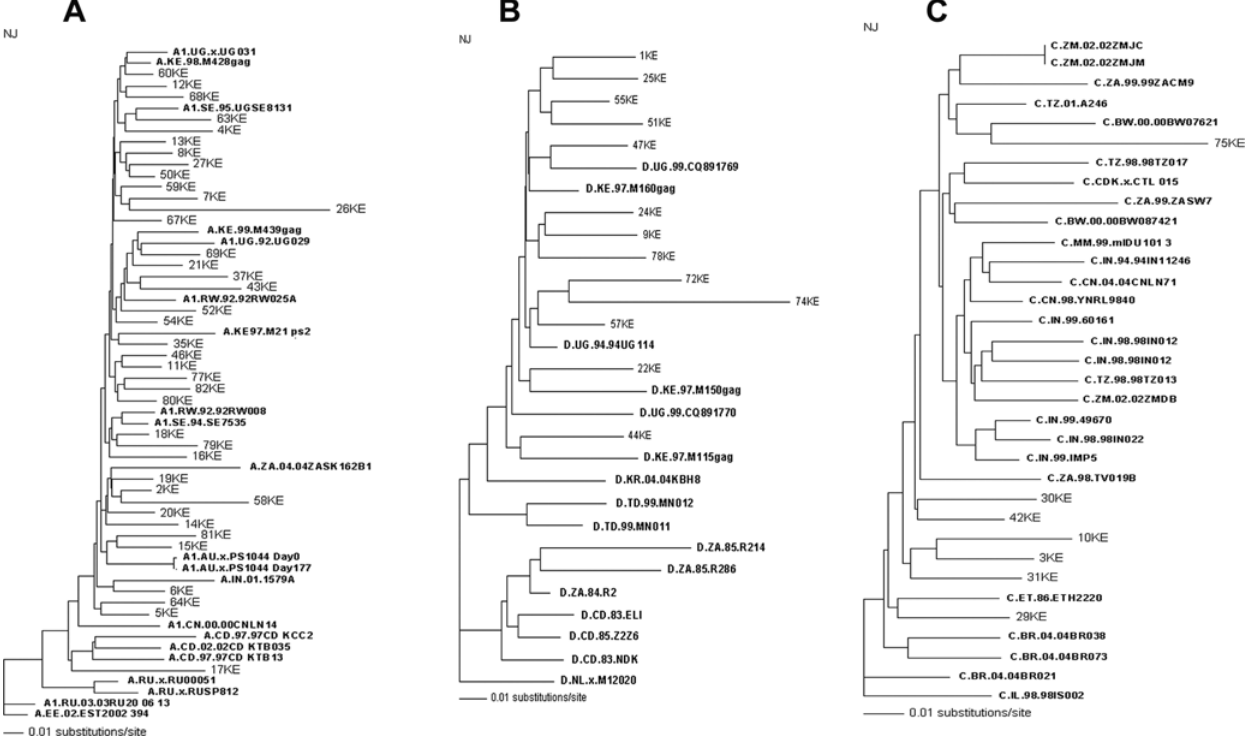
Figure 2. Neighbor-Joining Phylogenetic trees of the three most represented subtypes, A (Fig. 2A), D (Fig. 2B) and C (Fig. 2C), depicting geographical associations of the studied sample group with other global regions. Reference Sequences from Los Alamaos Database have been indicated in bold. Out groups selected for Fig. 2A, B, and C were, respectively, A.EE.02.EST2002 394, NL.x.M12020, and